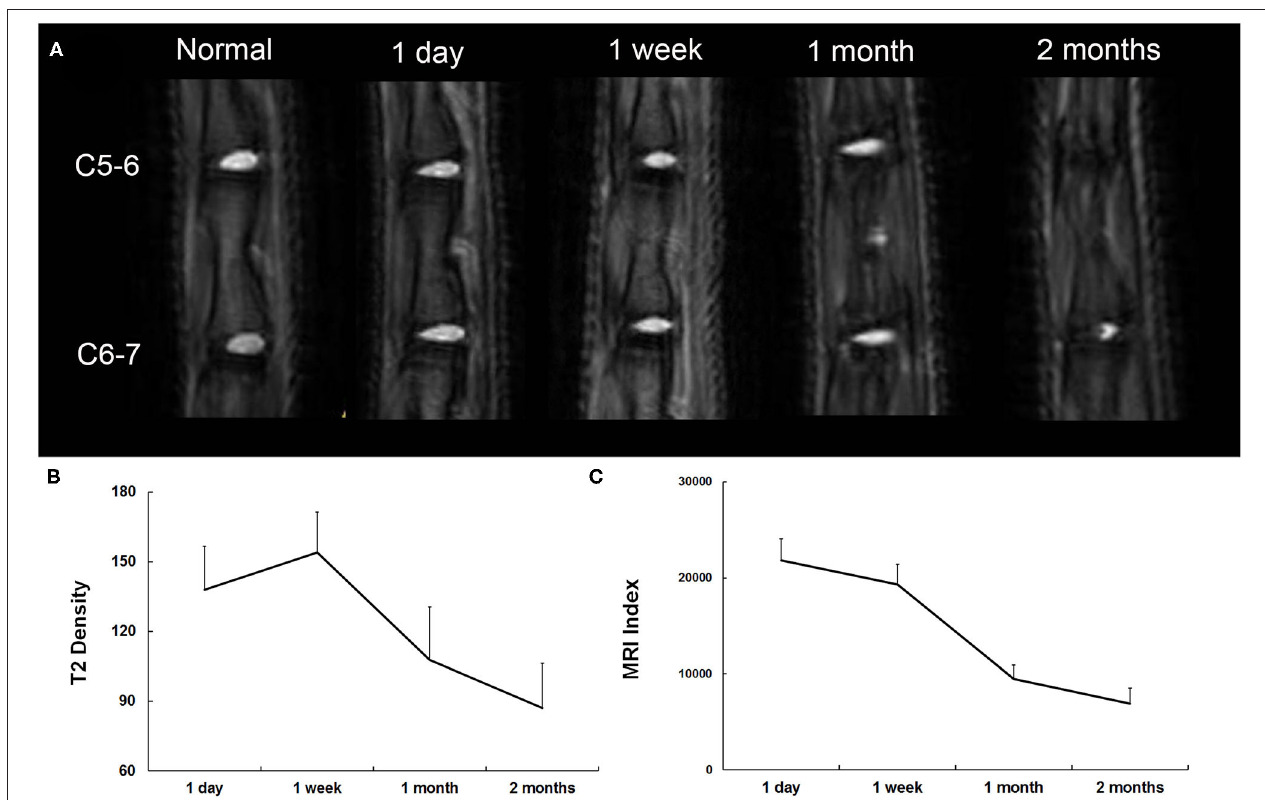
FIGURE 4 | (A) Representative serial T2-weighted midsagittal images of the caudal disks 1 day, 7 days, 1 month, and 2 months postinjury. (B) Quantitative analysis of T2 density. (C) Quantitative analysis of the MRI index.